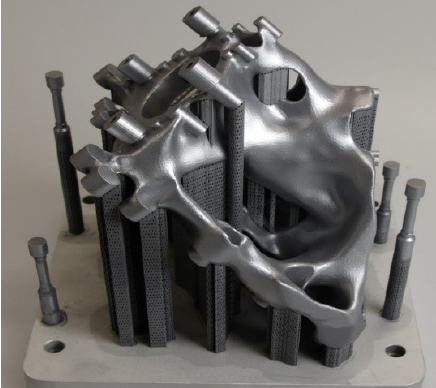
Fig. 3. Optical housing and tensile specimens made of AlSi40 after the AM process.